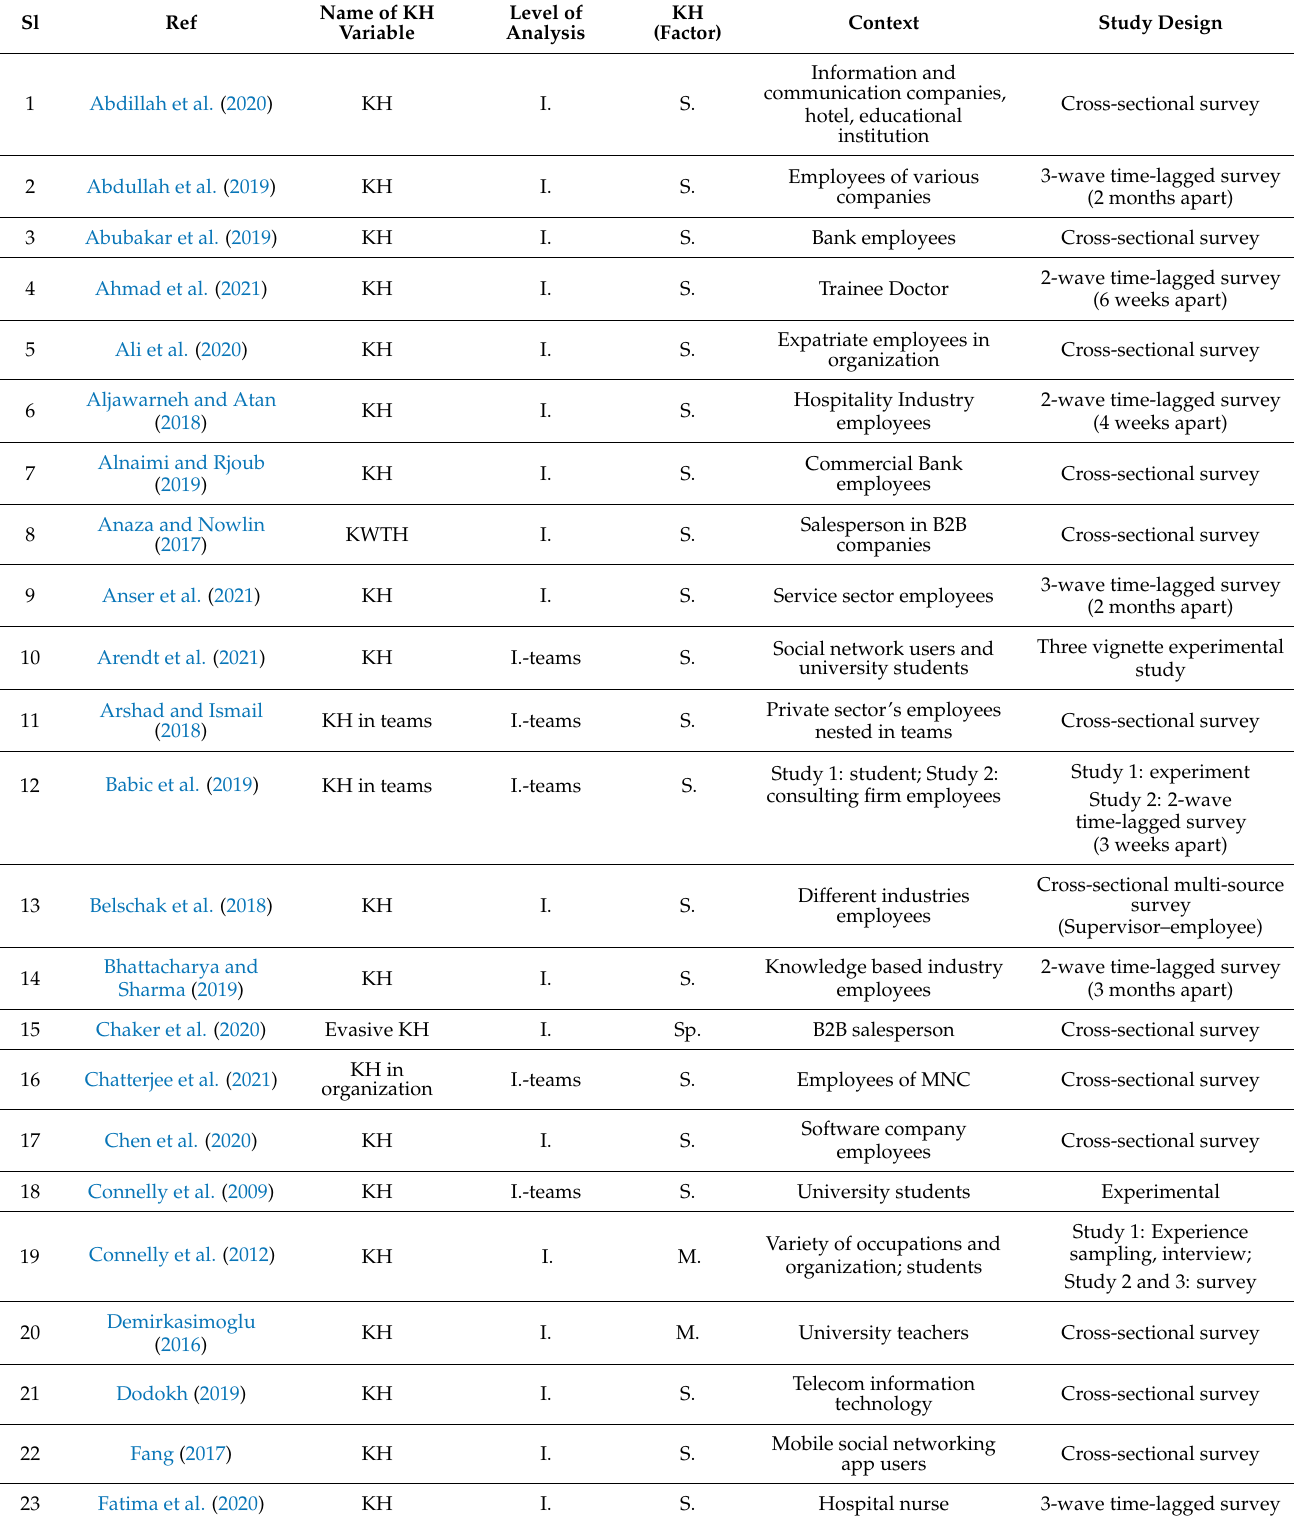
Table A1. Brief overview of the studies’